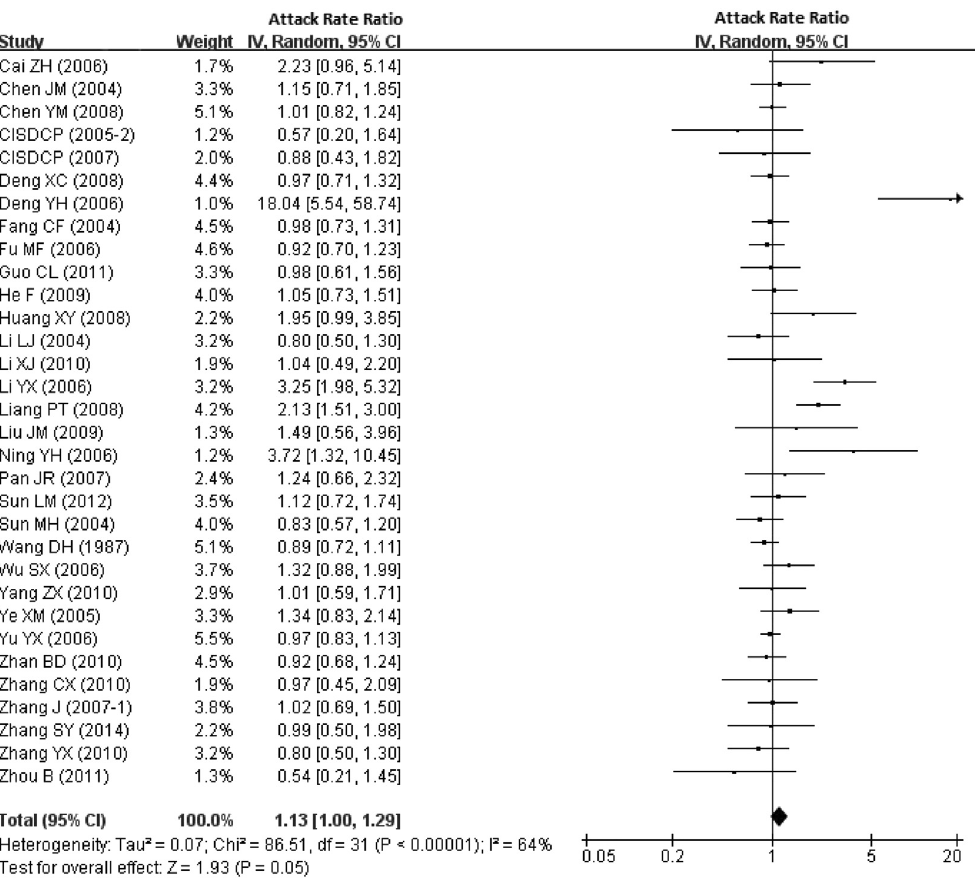
Fig. 5. Forest plot of male:female attack rate ratio. Attack rate: the number of new cases divided by the number of persons at risk during the whole outbreak.